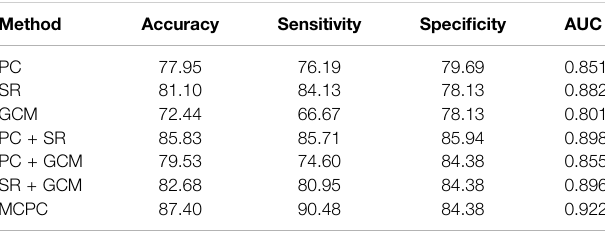
TABLE 1 | The Classi fi cation results of different methods.